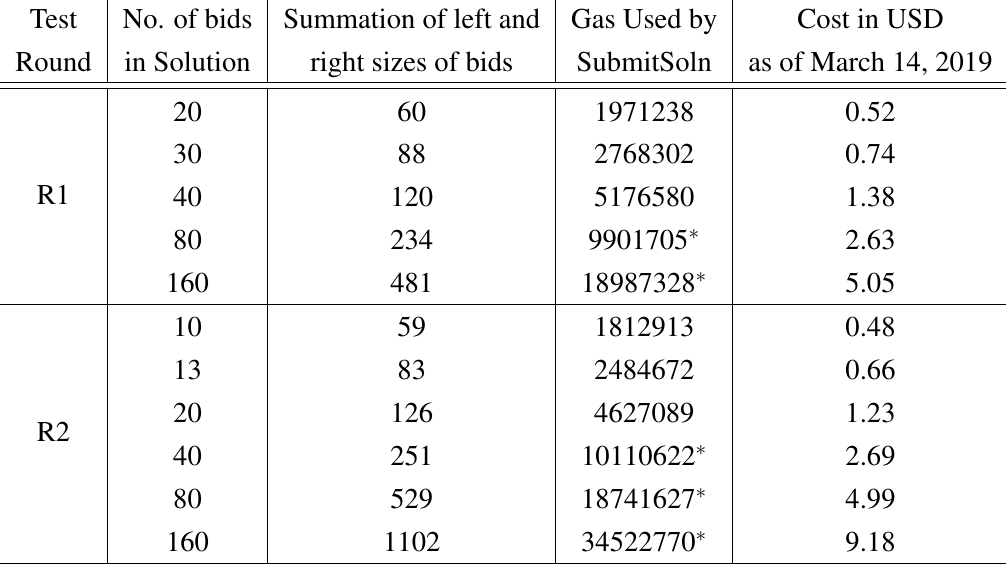
Table 3. Gas and USD costs of the SubmitSoln